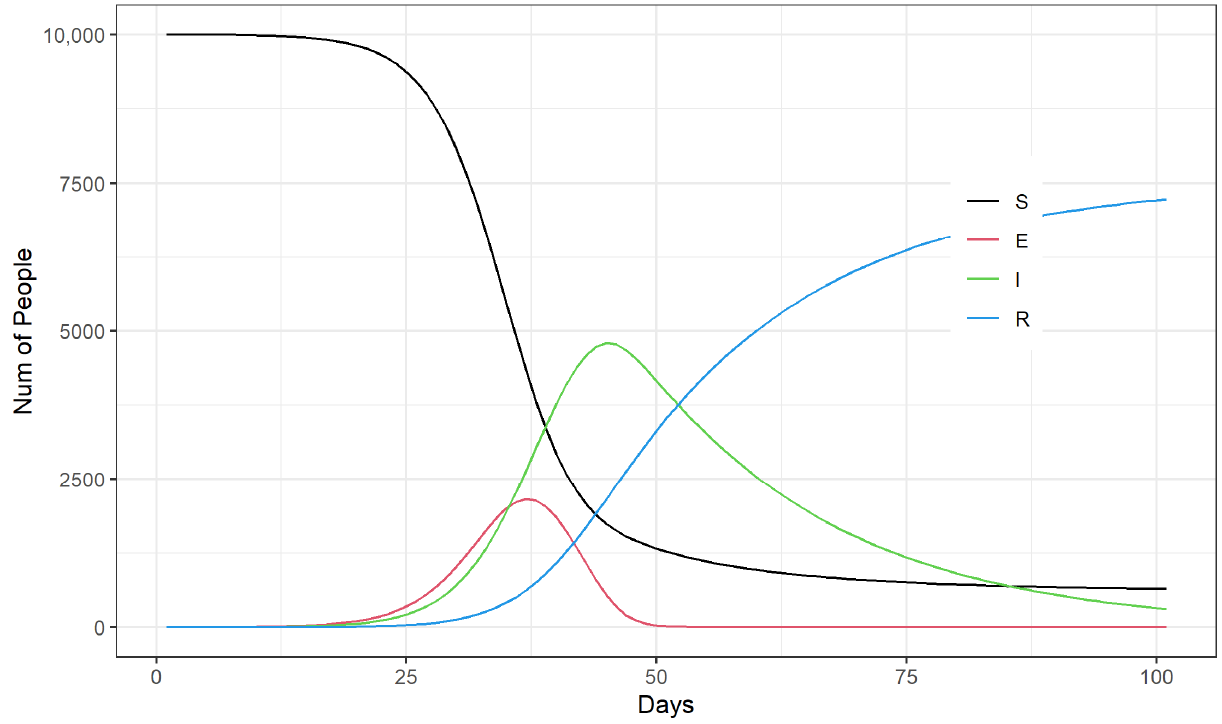
Figure A3. The influence of the daily testing capacity of 300 person on the evolutionary process of the epidemic; (The unit of the ordinate is “person”).